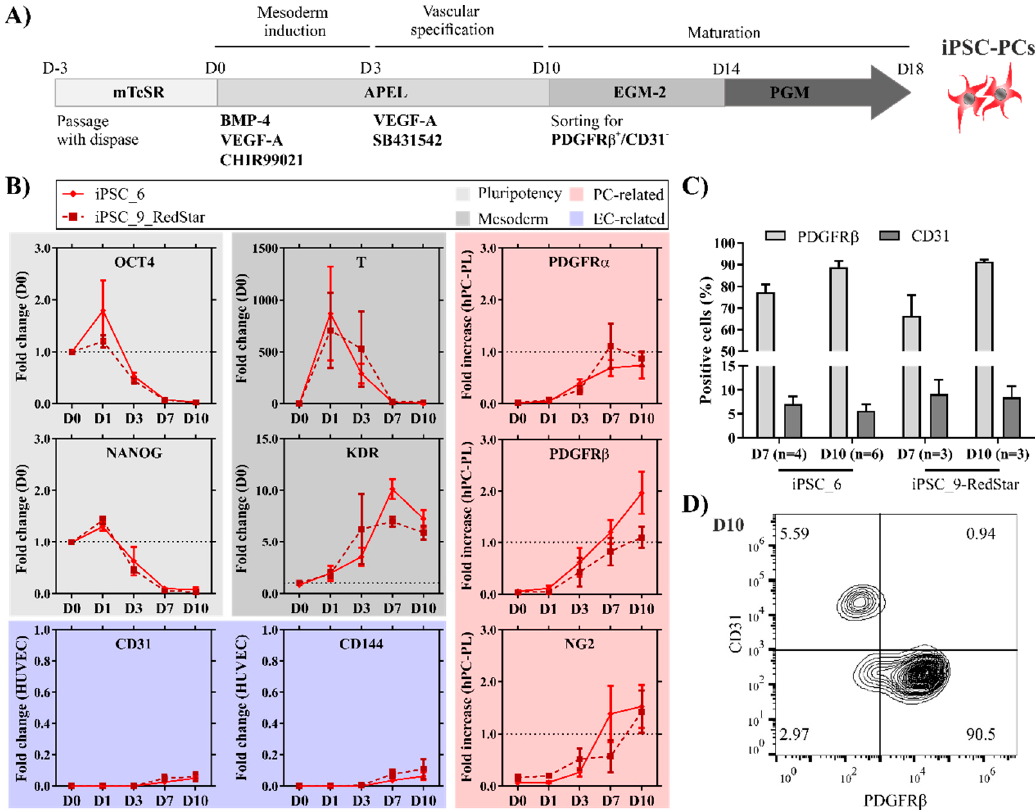
Figure 1. PC-like cells can be efficiently generated from human iPSCs. ( A ) Schematic representation of the differentiation process depicting the timeline as well as the used small molecules, growth factors, and media. ( B ) Pluripotency markers OCT4 and NANOG gradually decrease relative to the D0 of differentiation determined by qRT-PCR. Upregulation of early mesodermal marker T, followed by the upregulation of Kinase Insert Domain Receptor (KDR), indicates the induction of mesoderm. Expression levels of PC markers (PDGFR α , PDGFR β , and NG2) are expressed relative to human placental pericytes (hPC-PLs), and the EC markers (CD31 and CD144) are shown relative to HUVECs [35] ( n = 3–6). ( C ) Flow cytometric analysis for CD31 and PDGFR β on D7 and D10 in both iPSC lines used for differentiation ( n = 3–6). ( D ) Representative plot of stained (CD31, PDGFR β ) iPSC6-derived cells on differentiation D10 prior to fluorescence-activated cell sorting.